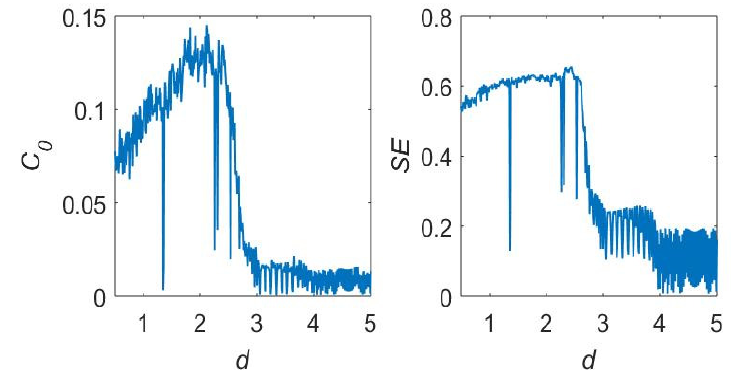
Figure 4. 0 C and SE complexity. Figure 4. C 0 and SE